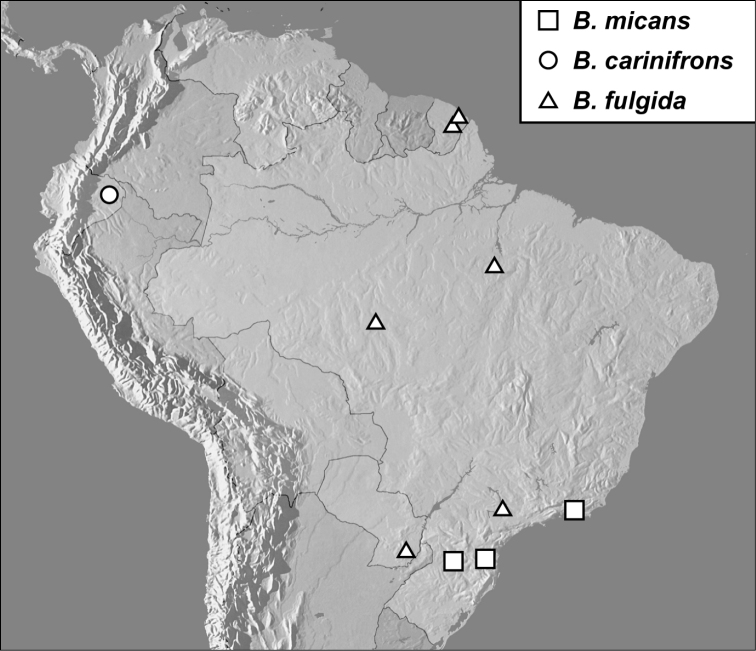
Baconia micans group records.